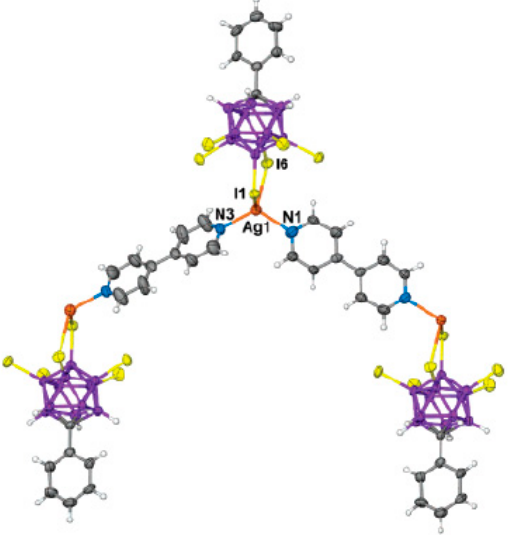
Figure 88. Fragment of X-ray structure of {Ag(4,4’-Bipy)[1-Ph-1-CB 11 H 5 -7,8,9,10,11,12-I 6 ]} n . Reprinted with permission from reference [75]. Copyright © (2007) American Chemical Society.